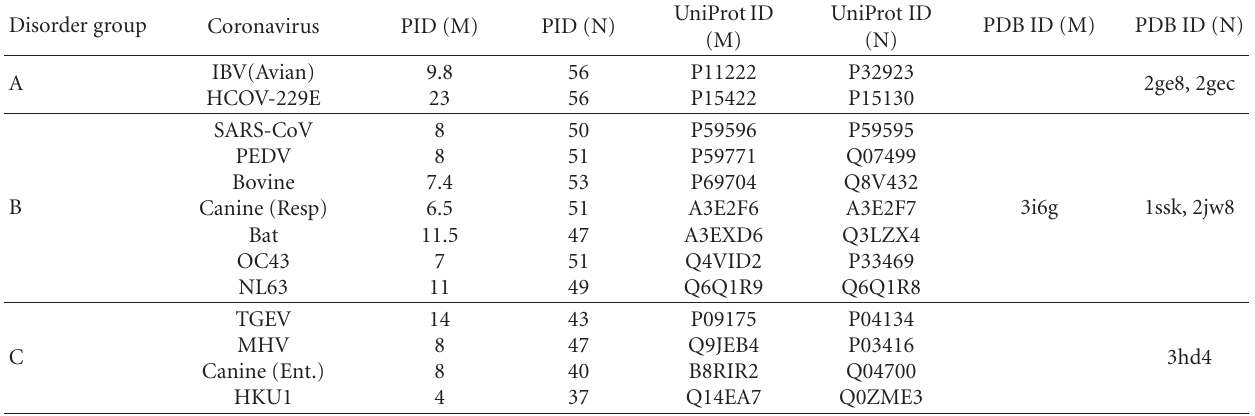
Table 4: Some of the coronavirus proteins analyzed in this